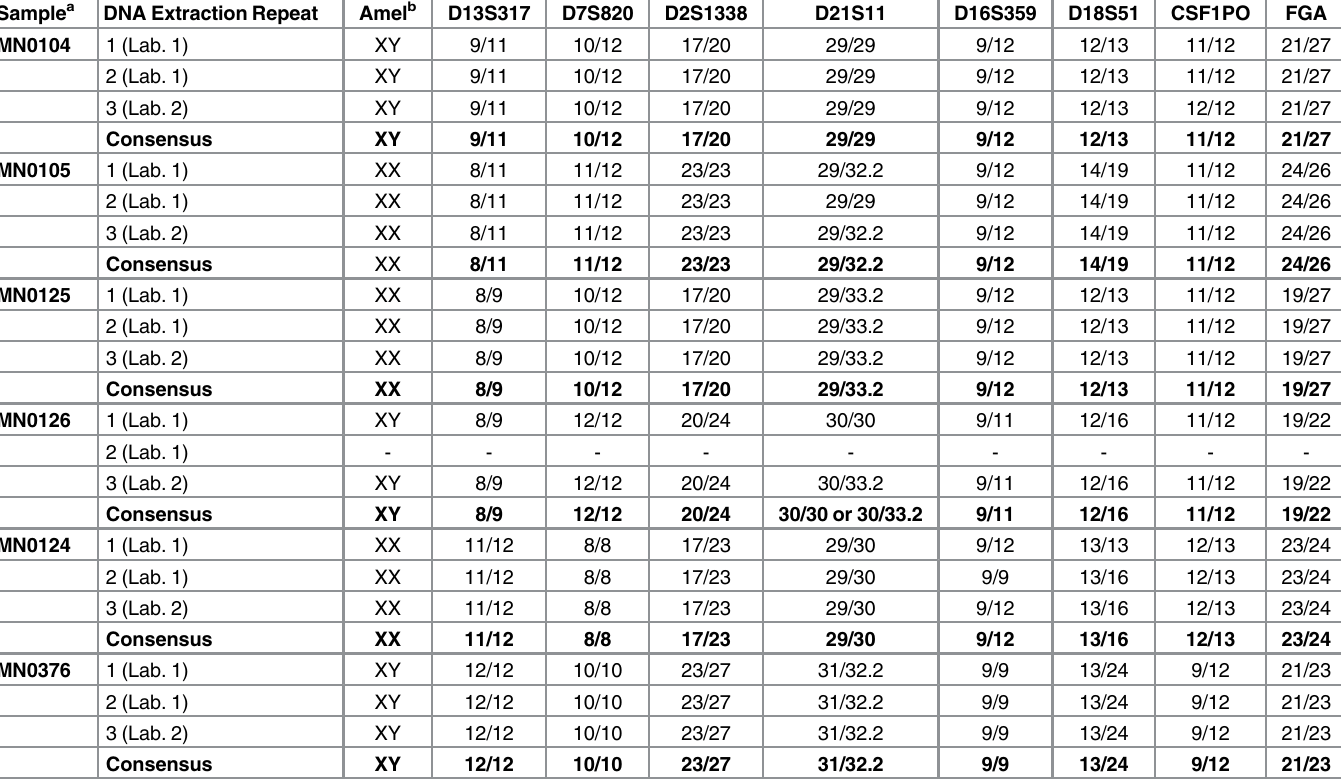
Table 4. A-STR allelic profiles of the Tavan Tolgoi bodies.